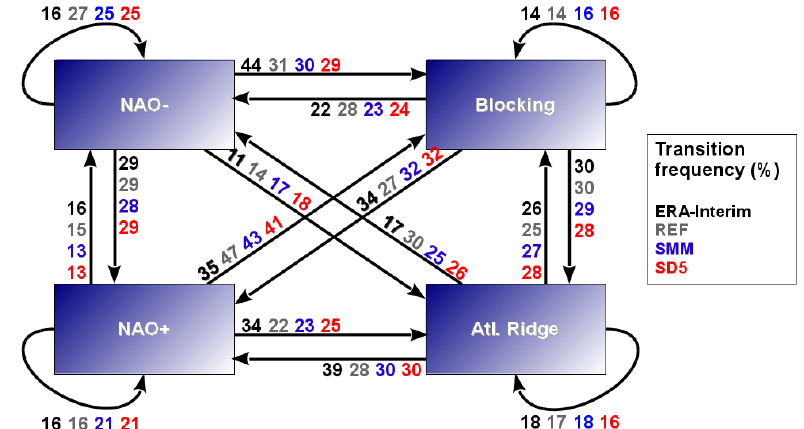
Figure 13. Frequency of weather regime transitions (in %) computed by discarding regimes shorter than 3 days (considered as transition days) over DJF 1979–2012. Results are shown for ERA-Interim reanalysis (in black) and experiments REF, SMM, and S5D (in grey, blue, and red,